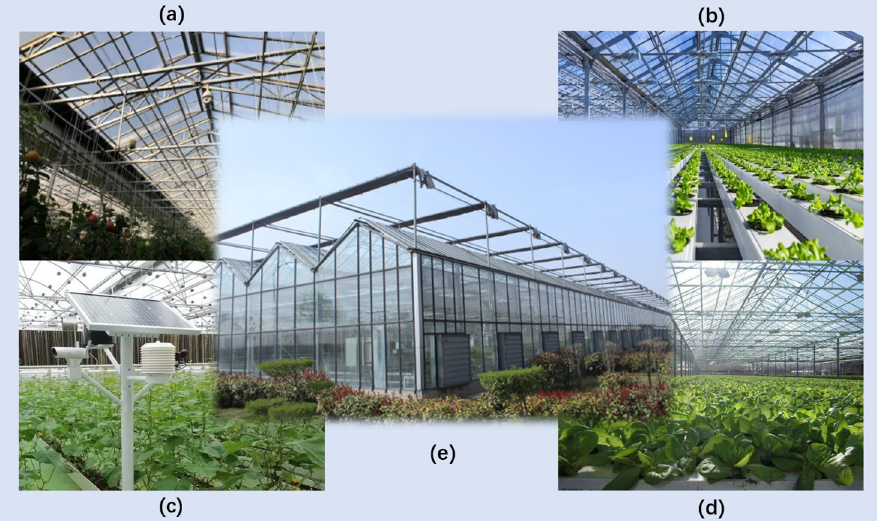
Figure 1. Schematic diagram of data collection environment. ( a – d ) show the sensors used to collect data on temperature, humidity, light, CO 2 , and light intensity at the top, ground, front, and back of the greenhouse, respectively; ( e ) shows a panoramic view of the greenhouse.